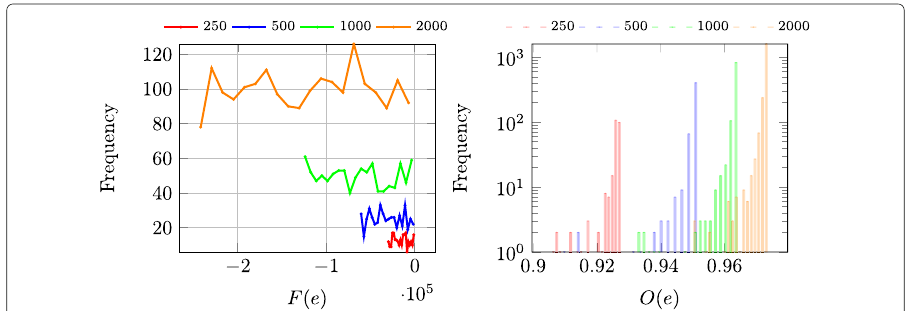
Fig. 5 Forman Ricci curvature F (left) and Ollivier Ricci curvature O (right) distributions of the Erdös Rényi model for directed hypergraphs introduced in Algorithm 1